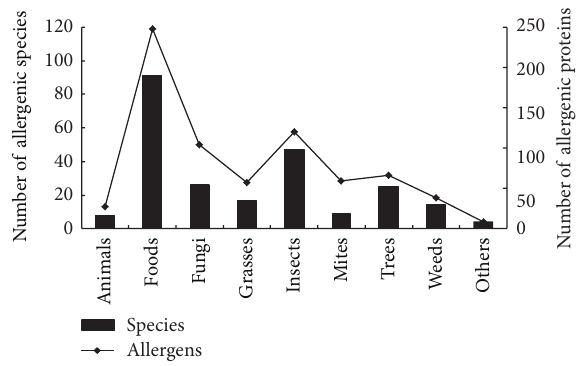
Figure 2: The consistency of two distributions: allergen related species distribution ( ◼ ) and the distribution of the number of allergenic proteins within each species ( 󳵳 ). The allergens data were downloaded from the IUIS website (http://www.allergen.org/) on June 20, 2012. Estimated parameter for Kolmogorov - Smirnov test is 0.06642, less than the threshold values ( 𝐷 𝑛,0.01 = 0.1212, 𝐷 𝑛,0.05 = 0.1011), thus statistically validating the consistency of the two